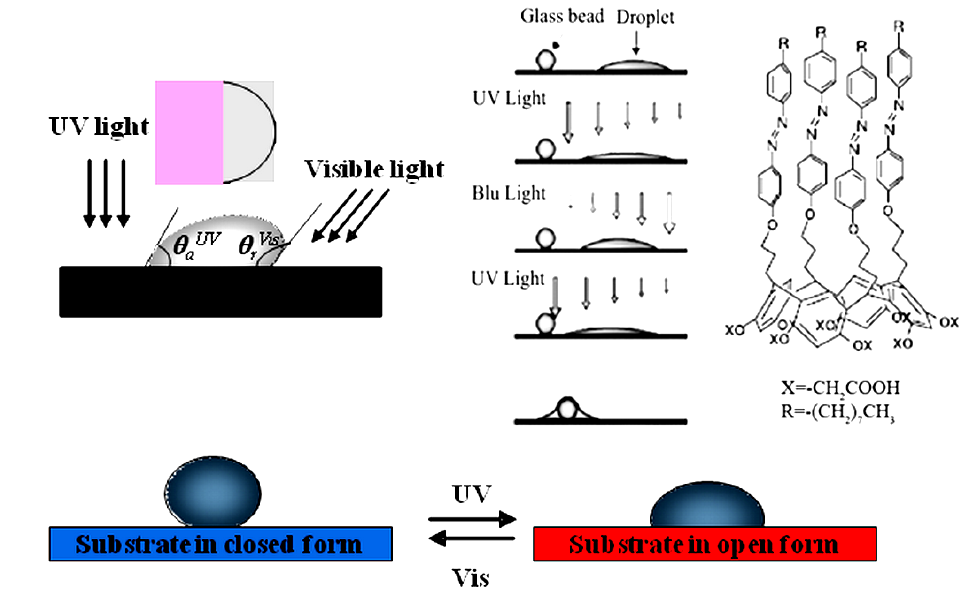
Figure 8. Photo-driven motion of individual liquid droplets (Adapted from